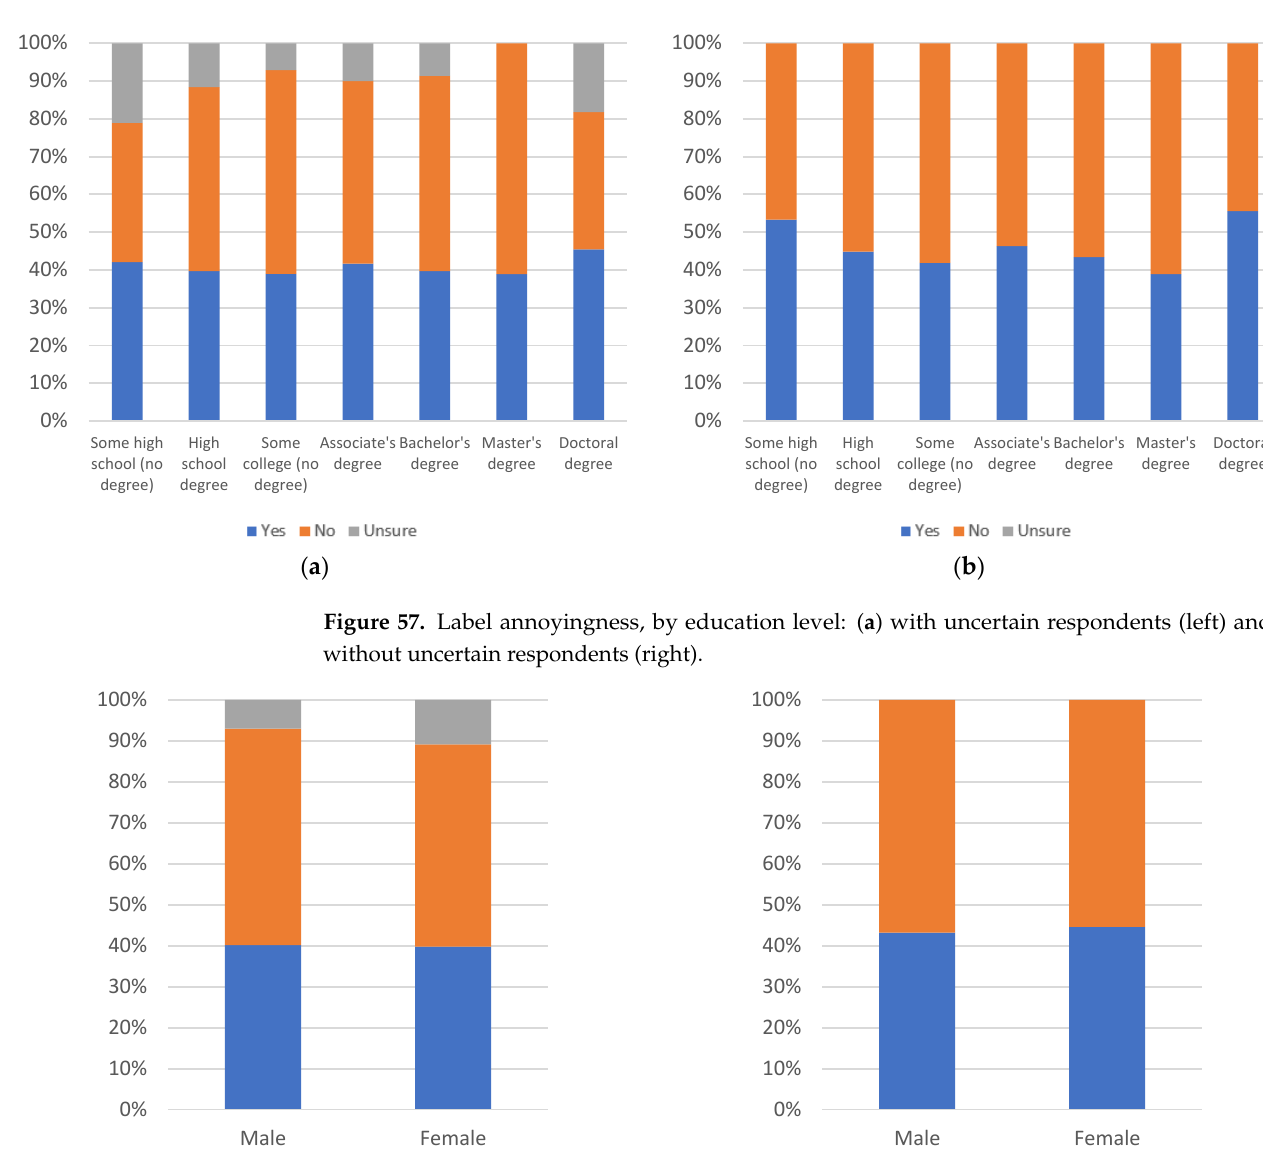
Figure 56. Label annoyingness, by age group: ( a ) with uncertain respondents (left) and ( b ) without uncertain respondents (right).